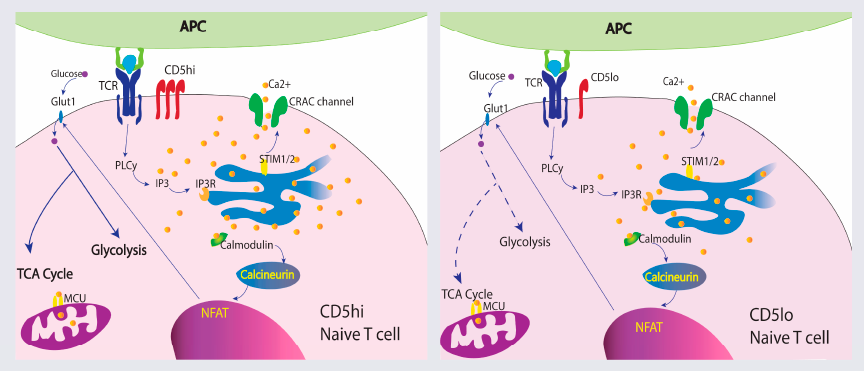
Figure 3. CD5 expression levels in naïve T cells may influence T cell metabolism and